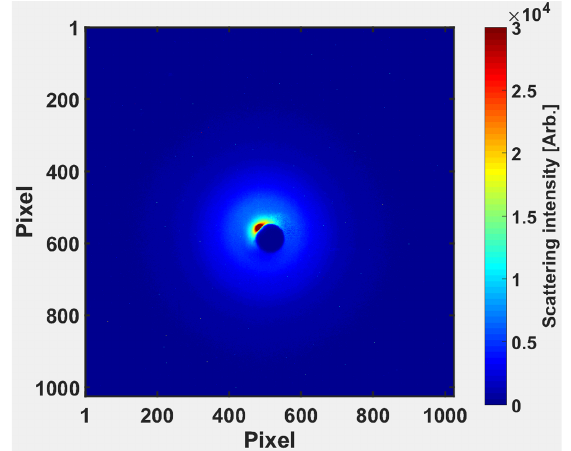
FIG. 7. Raw CH 2 I 2 diffraction pattern averaged between 450 and 600 fs. The electron beam is directed to the top-left corner of the hole in the phosphor screen in order to access some of the signal in the low- s